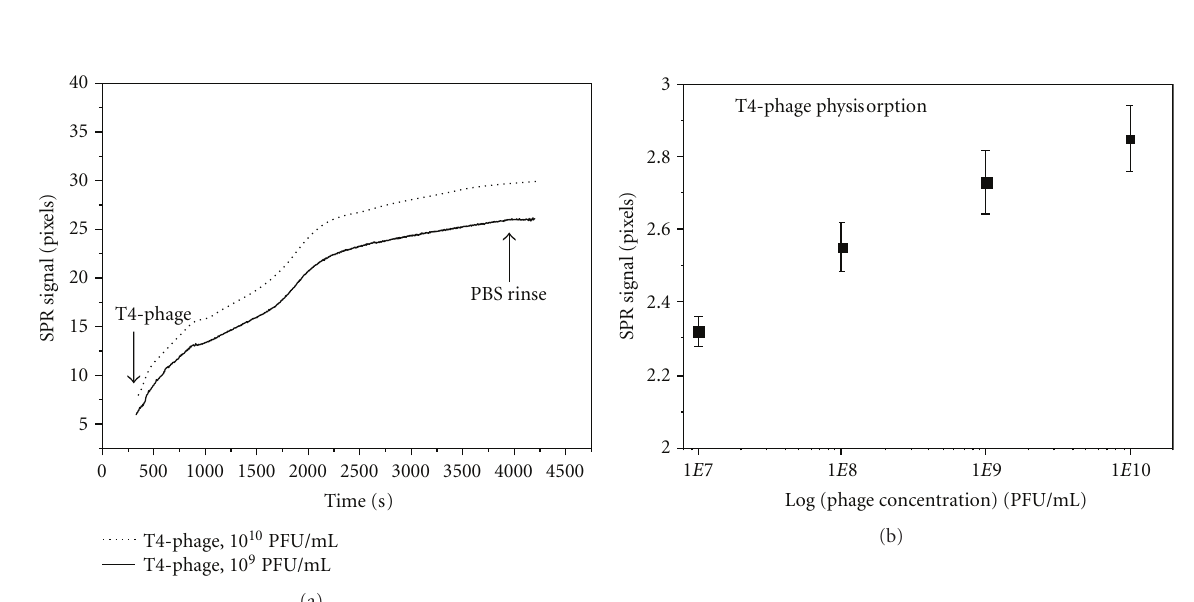
Figure 2: (a) SPRi signal over time for di ff erent T4-phage concentration physisorbed on the 16 gold spots. (b) Calibration curve of SPRi signal versus di ff erent concentration of T4-phages physisorbed on the 16 gold